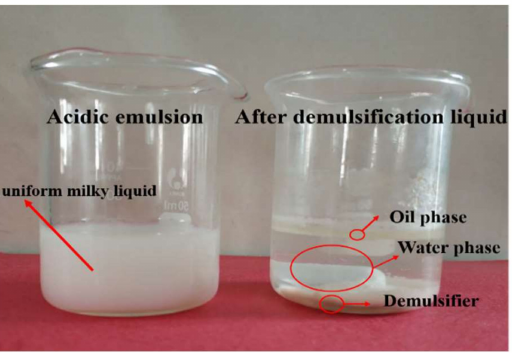
Figure 6. Photographs of the acidic oil-in-water emulsion and after demulsification by Ti-Mt-APTES-0.10.